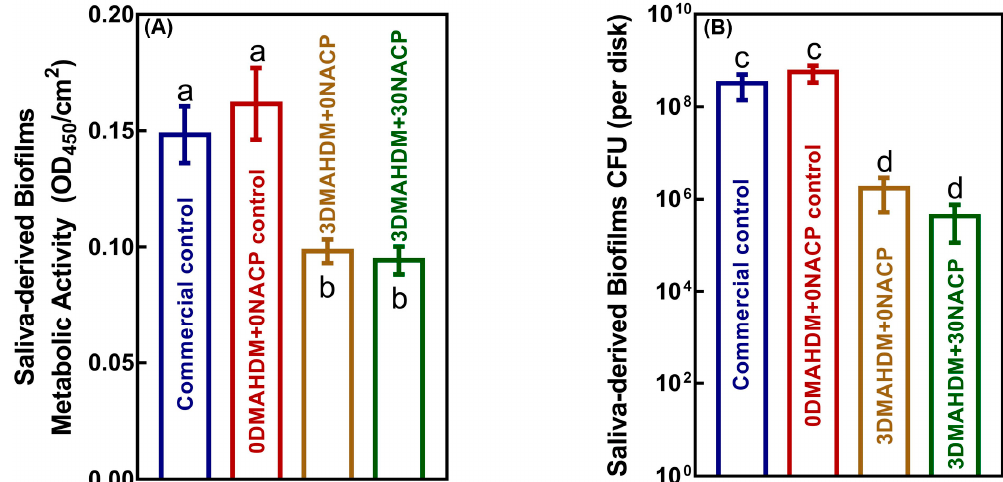
Figure 3. Antibacterial effects of composites on saliva-derived biofilm. ( A ) MTT metabolic activity and ( B ) colony-forming units (CFU) of saliva-derived biofilms on composites (mean ± SD; n = 6). Bars with disparate letters indicate data are significantly different ( p < 0.05).